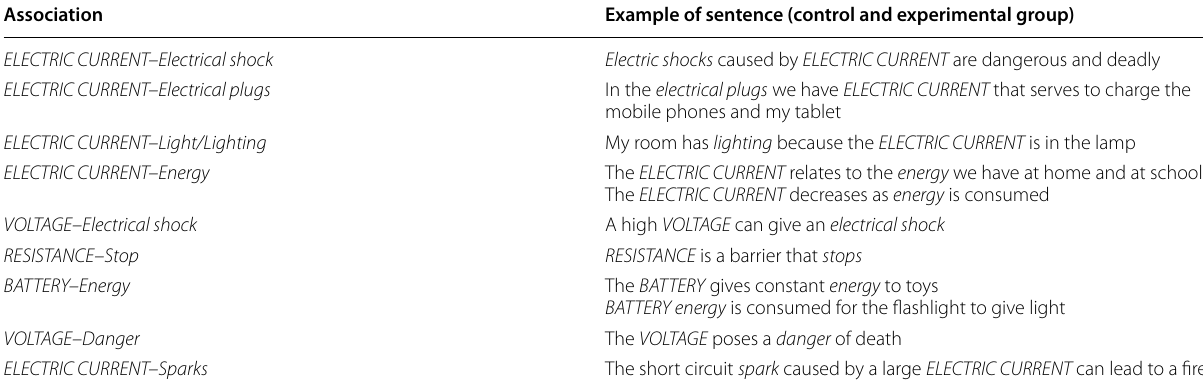
Since the sentences written by students belonging to the control and experimental group were similar, it was decided to consider them as being representative of both groups